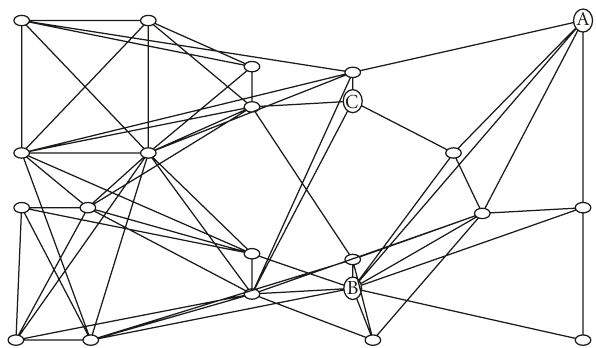
Figure 1: Connectivity in the PowerBench testbed. Links shown have at least 95% packet reception in both